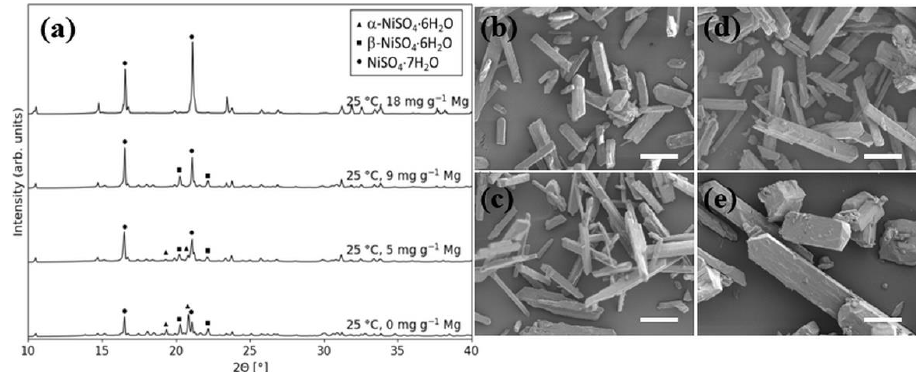
Figure 7. ( a ) XRD spectra of nickel sulfate phases precipitated with 0.2 g α -NSH6 seeds at 25 ◦ C in the absence and presence of Mg at indicated concentration levels. SEM images of crystals collected from corresponding experiments; ( b ) no magnesium, ( c ) 5 mg g − 1 Mg, ( d ) 9 mg g − 1 Mg, and ( e ) 18 mg g − 1 Mg. Scale bar: 100 µm.